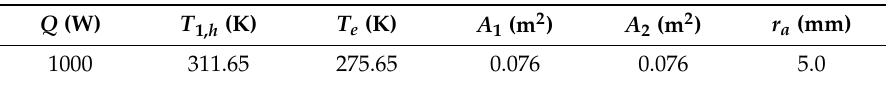
Table 2. Characteristic parameters of the pipeline network.